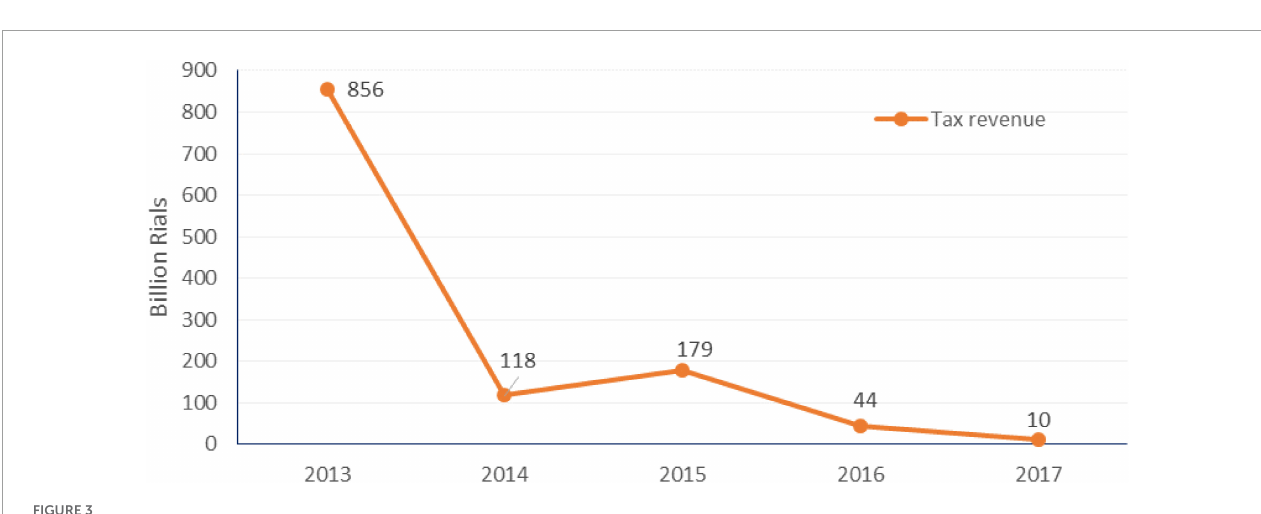
FIGURE3 Sugary soft beverage tax revenue from 2013 to 2017 in